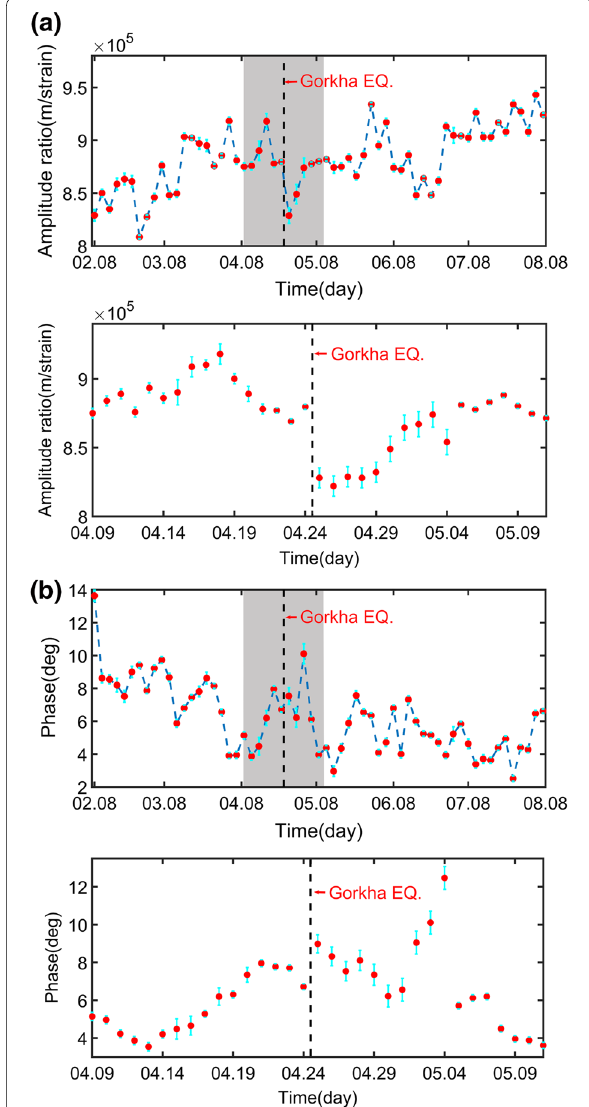
Fig. 8 Amplitude ratio ( a ) and phase response ( b ) of LJ well change with time at M2 wave frequency. Amplitude response is amplitude ratio of earth tide and water level. Dotted line shows the origin time of 2015 Gorkha earthquake (Beijing time). Blue error bars indicate the error of the tidal analysis. Bottom panels in figures a and b are the magnifications of the corresponding period of the gray background in the top panels,